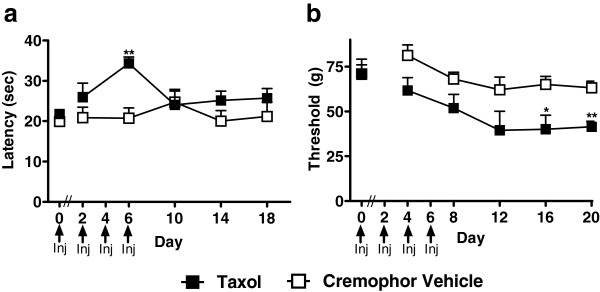
Paclitaxel induces mechanical allodynia without producing hypersensitivity to heat. a. Paclitaxel treatment produced transient heat hypoalgesia but no long-term changes in paw withdrawal latencies to heat whereas b. the same animals developed mechanical allodynia. Inj indicates days when injections of paclitaxel or cremophor vehicle occurred. Taxol; paclitaxel. *P < 0.05, **P <0.01 vs. Cremophor Vehicle, (ANOVA). N = 6 per group.